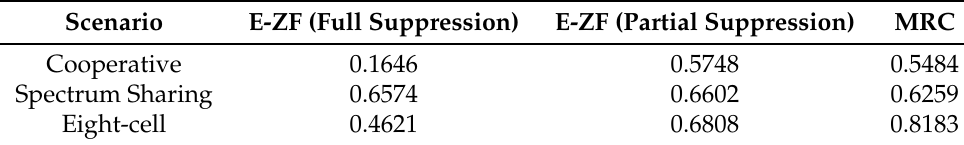
Table 3. Standard deviation values for the spectrum efficiency per user.